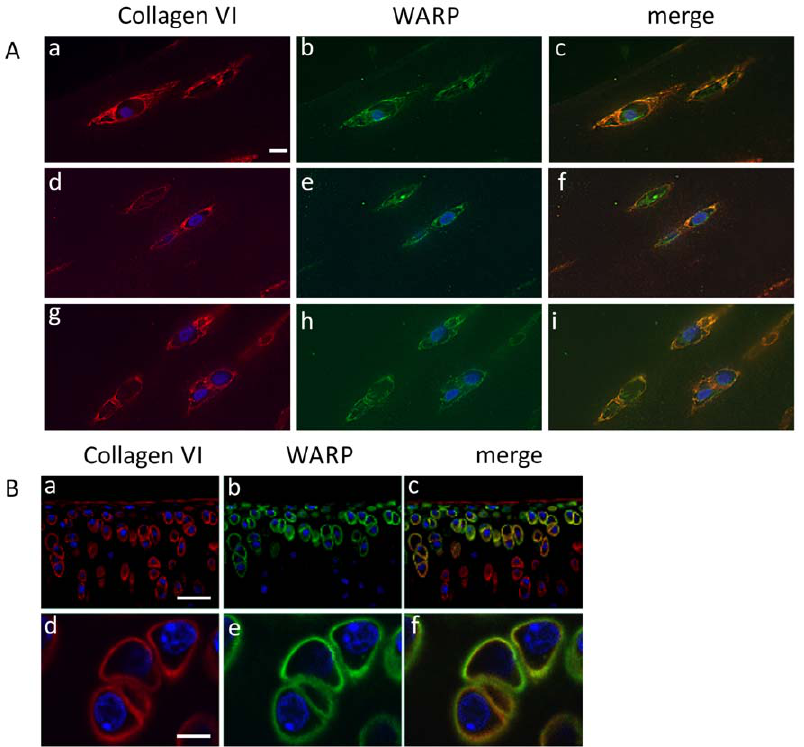
Figure 1. Immunohistochemical localization of WARP and collagen VI in articular cartilage. A, Superficial zone human articular cartilage was stained for collagen VI (panels a, d and g) and WARP (panels b, e and h). The merged images show clear co-localization of collagen VI and WARP in the pericellular environment (panels c, f and i). The scale bar shown in panel (a) is 100 m m. B, Mouse tibial articular cartilage stained with collagen VI (panels a and d) and WARP antisera (panels b and e). Merged images show co-localization of collagen VI and WARP in the chondrocyte pericellular matrix (panels c and f). Scale bar in panel (a) is 200 m m and in (d) 50 m m.